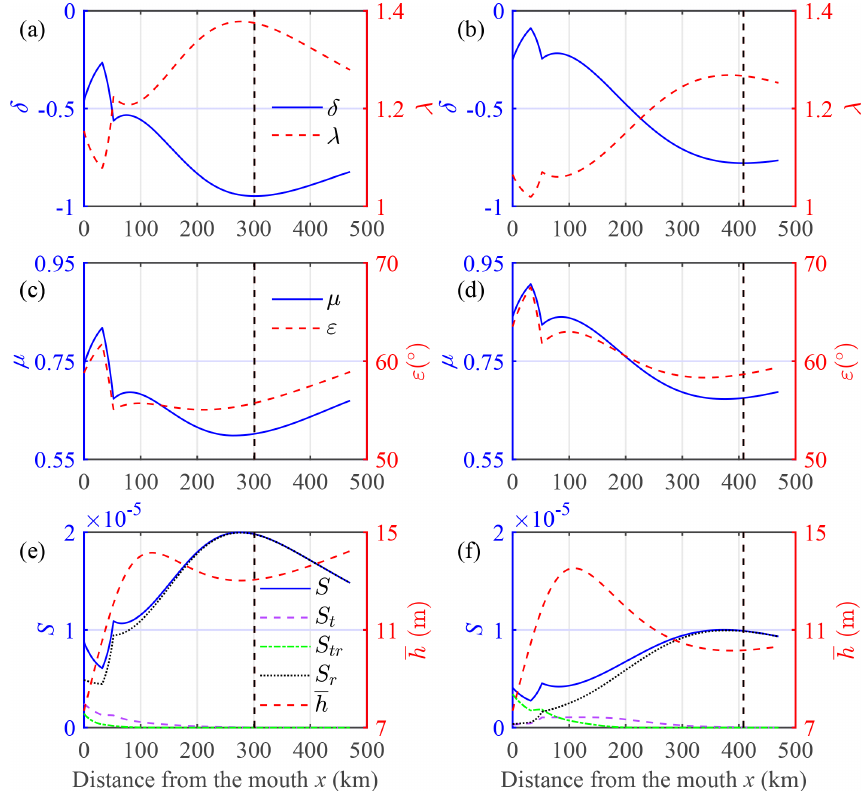
Figure 8. Longitudinal variation of the main tide–river dynamics (a, b, c, d) , as well as the contributions of tidal and riverine forcing to the residual water level slope and the water depth (e, f) for the wet (a, c, e) and dry seasons (b, d, f) in the Yangtze River estuary. The dashed lines in each sub-plot represent the critical position for maximum tidal damping (corresponding to the minimum value of damping number δ